Question: What does this figure show? Answer in one sentence.
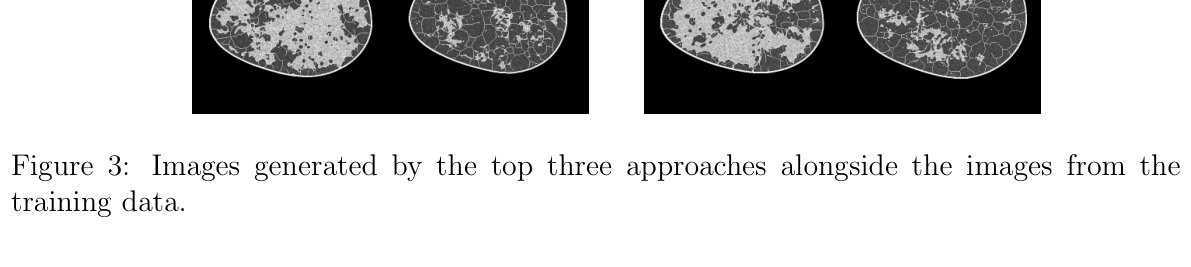
Answer: shows the images generated by the top three approaches. It can be seen that they display a high degree of perceptual similarity to the provided training images. However, they still retain imperfections, as identified and discussed further in Section IV.E. The FID scores for the 12 unique submissions are reported in Figure 4a. Boxplots of memorization measure values computed for 3,000 synthetic images with respect to the training data are shown in Figure 4b. The submissions that produced images with memorization measure